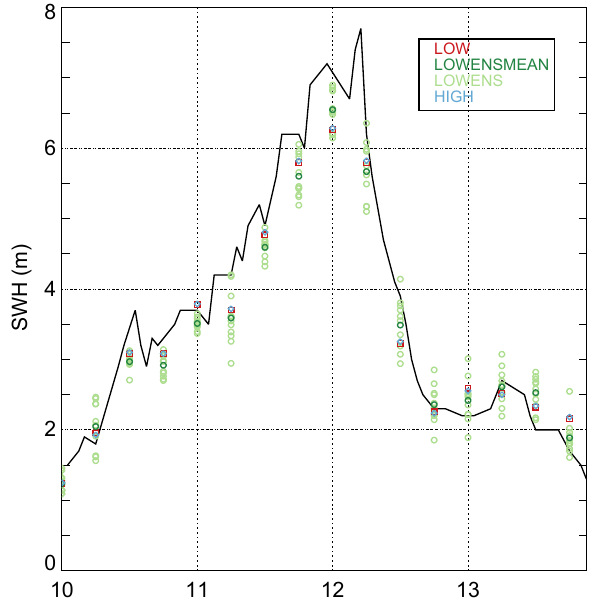
Figure 10. Observed SWH for the northern Baltic during the period from 10 to 13 January 2017, which included the Toini storm. Open circles are 48h